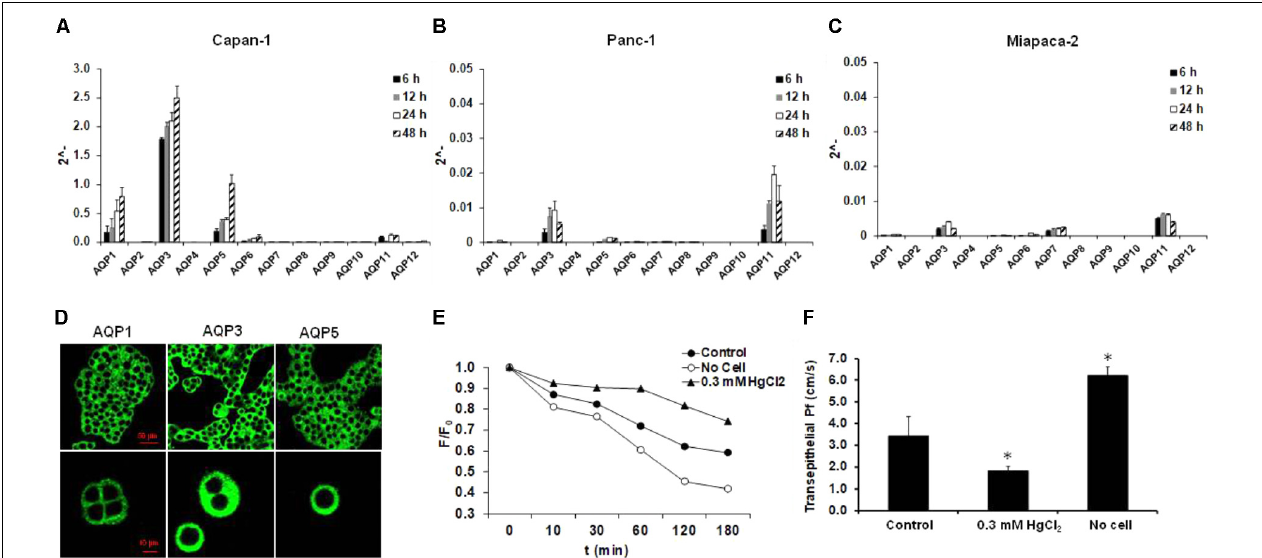
FIGURE 1 | Expression and activity of AQPs in pancreatic ductal cells. Expression of different AQP isoforms was investigated by real-time PCR in (A) Capan-1, (B) Panc-1, and (C) Miapaca-2 pancreatic ductal cell lines, 6, 12, 24, and 48 h after the plating the cells. Data represent mean ± SEM of three, independent experiments. (D) Immunofluorescence staining of Capan-1 cells using FITC-conjugated anti-AQP1, -3, and -5 antibodies. (E) Osmotic water movement was investigated in Capan-1 cells. Representative graph shows changes in the fluorescence intensity of the apical solution, at different time points, in the present (triangle) and absence (black circle) of luminal HgCl 2 (0.3 mM). To estimate the changes, the fluorescence intensity (F) was normalized to the initial value (F 0 ). Transwell without cells was used for absolute positive control (open circle). (F) Summary of the P f values obtained from the experiments in (E) . Data represent mean ± SEM of three, independent experiments. ∗ p ≤ 0.05 vs.